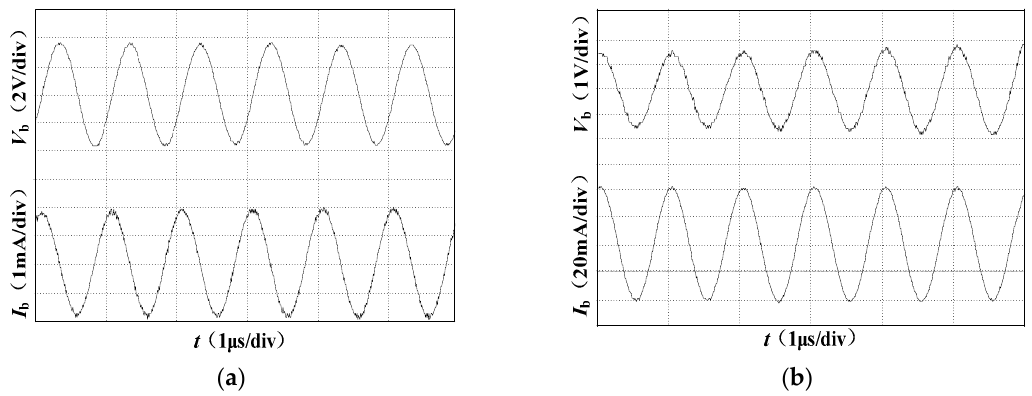
Figure 5. Waveforms of the bearing voltage and the bearing current ( a ) at not breakdown ( b ) at